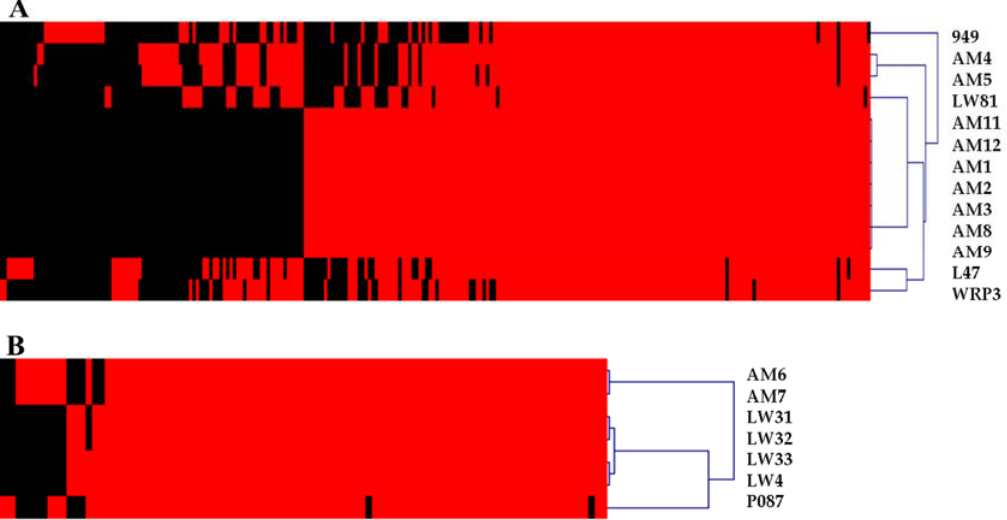
Figure 2. Heatmap indicating the presence (red) or absence (black) of individual protein families encoded by members of the 949 ( A ) and P087 ( B ) groups. Distinct phylogenetic clusters of the 949 and P087 phages can be identified using this approach that are consistent with the phylogeny based on overall nucleotide content presented in Figure 1.